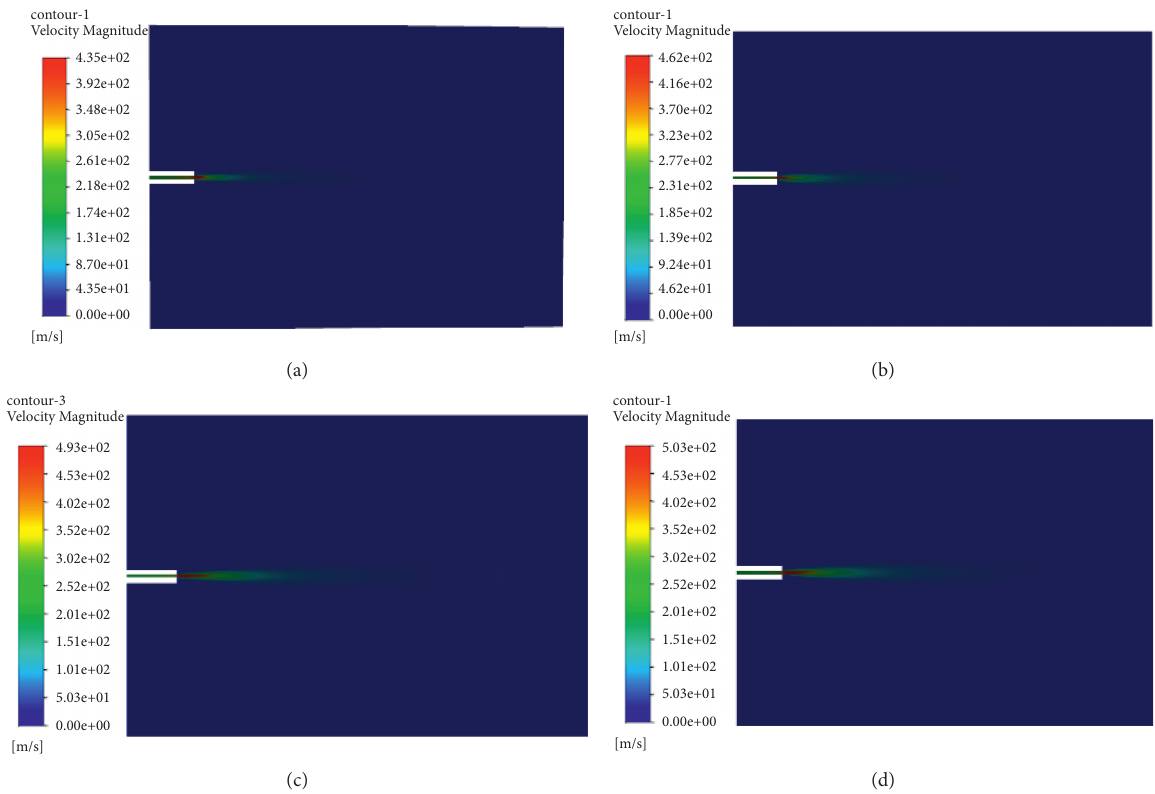
Figure 2: Results of gas velocity with different blasting pressures. (a) Results of gas velocity with the blasting pressure of 0.5MPa. (b) Results of gas velocity with the blasting pressure of 0.6 MPa. (c) Results of gas velocity with the blasting pressure of 0.7MPa. (d) Results of gas velocity with the blasting pressure of